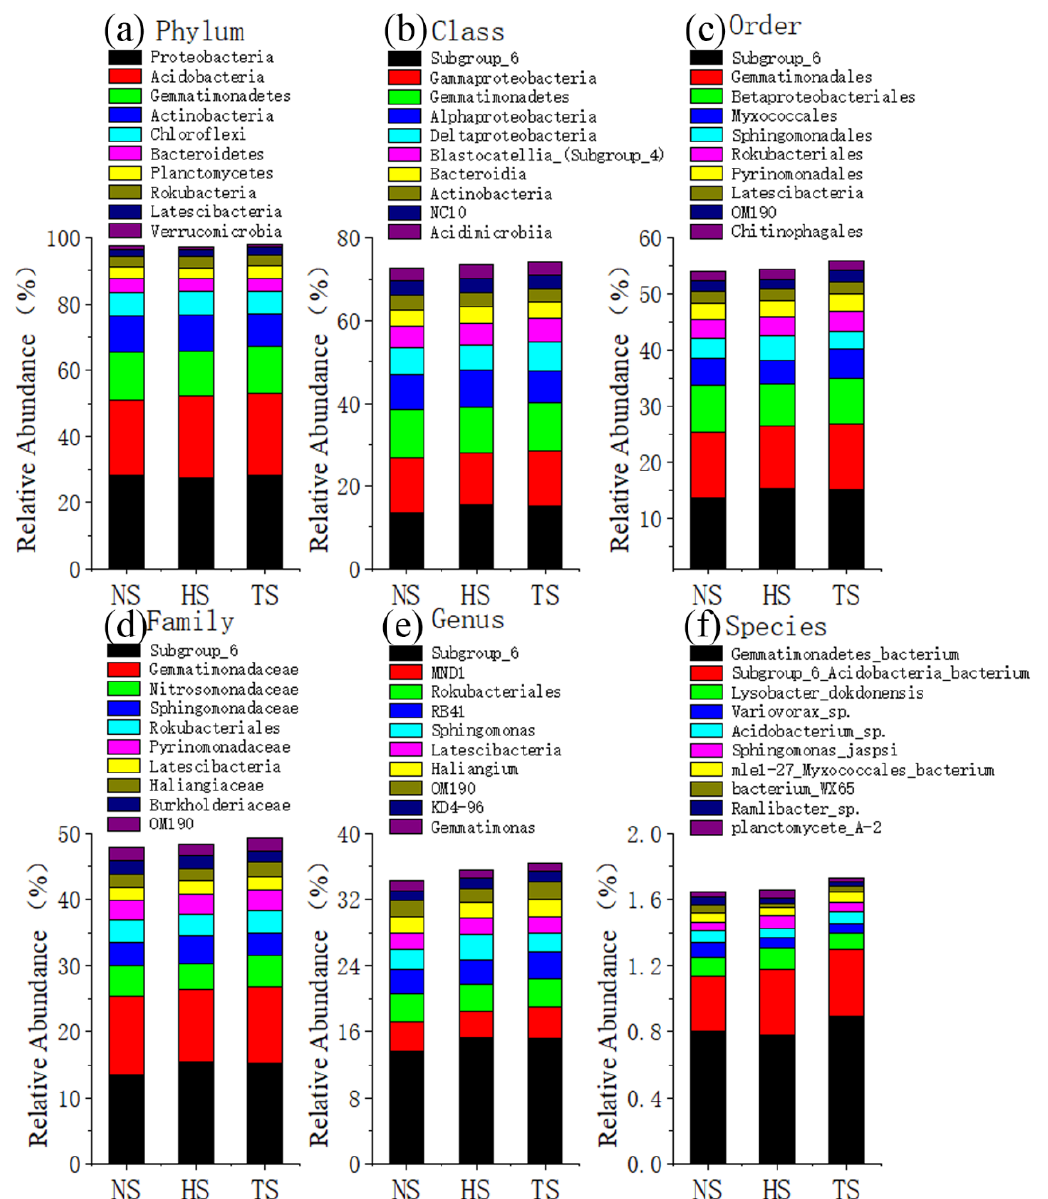
Figure 5. Effect of straw retention on the relative abundance of soil bacteria. ( a ), the relative abundance of soil bacteria at the Phylum level; ( b ), the relative abundance of soil bacteria at the Class level; ( c ), the relative abundance of soil bacteria at the Order level; ( d ), the relative abundance of soil bacteria at the Family level; ( e ), the relative abundance of soil bacteria at the Genus level; ( f ), the relative abundance of soil bacteria at the Species level.